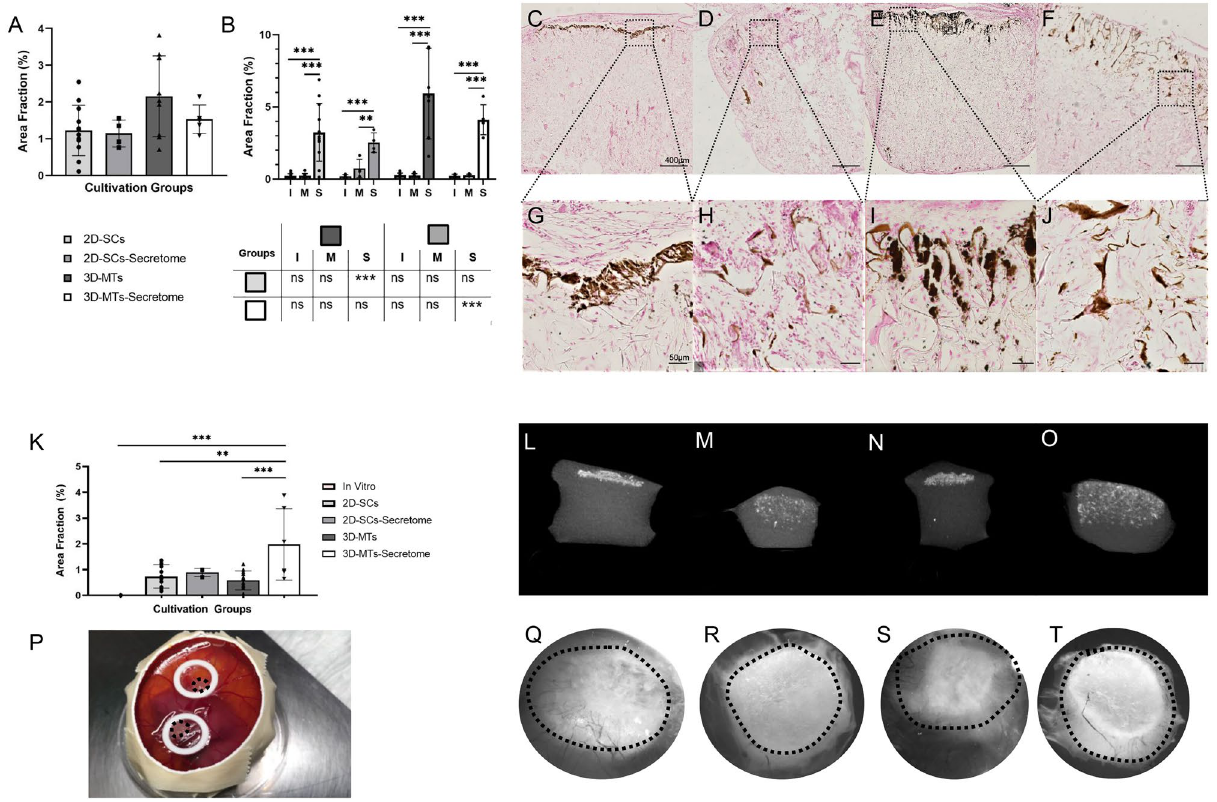
Figure 5. Histological and microCT analysis of the calcification potential of ASCs in the natural collagen scaffold (Optimaix). Calcification was assessed with Von Kossa histological analysis ( A – J ) and a microCT analysis ( K – O ). Results are presented in a group comparison of the total scaffold ( A , K ) and more specified in differing three ROIs (interface (I), middle (M) and the surface (S); shown in B ). Significance of intra-group calculations are demonstrated within the graph whereas inter-group differences with its corresponding ROIs are shown on the separate table, bellow the graph ( B ). The results are illustrated with an exemplary out-take of each cultivation group using single-cells ( C , G , L , Q ), 2D-SCs secretome ( D , H , M , R ), 3D-microtissues ( E , I , N , S ), 3D-MT secretome ( F , J , O , T ). An exemplary part of the surface region is shown for each group ( G – J ). Two scaffolds were placed as onplants on the CAM of each chicken egg ( P ). View of the scaffolds from the top shows a tendency of calcification ( Q – T ). Dotted line marks edge of scaffolds. The scale bar was defined with 400 µm in the overview examples ( C – F ) and 50 µm for the more detailed examples ( G – J ). Statistical results were established with a one-way ANOVA considering only one independent factor and a two-way